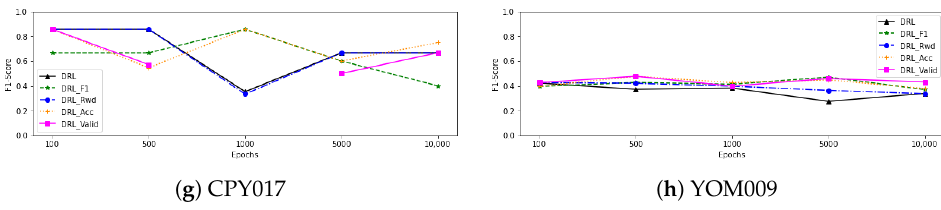
Figure 4. F1-score when increasing the learning epochs at each station.